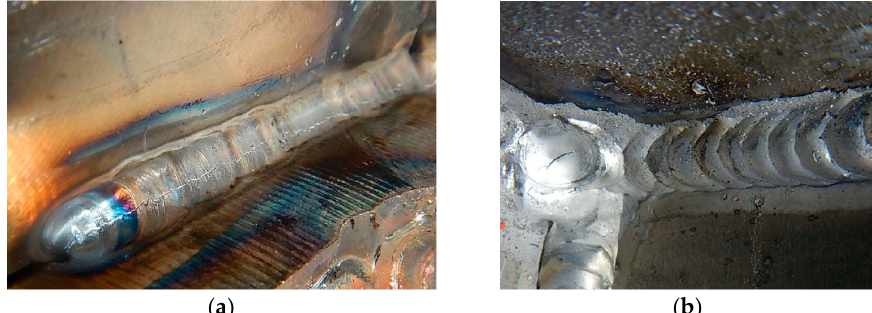
Figure 3. Cracks: ( a ) longitudinal surface crack produced in the weld metal by excessive clamping between plates with different thicknesses (thicknesses of 40 mm and 100 mm) and welded with TIG process without properly preheating the plates; ( b ) transverse crater crack produced in the weld metal by an abrupt interruption of the arc causing tensile stresses across the weld surface.